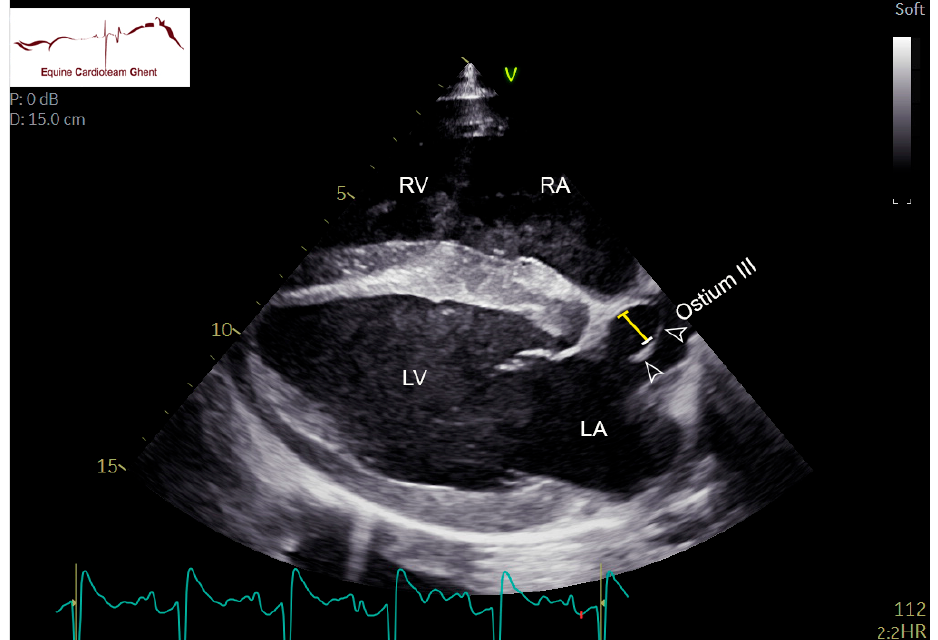
Figure 1. Right parasternal four-chamber (R-4C) view of the foramen ovale in a 2-day-old healthy foal. The arrowheads indicate the fluttering septum primum at the base of the ostium of pulmonary vein III (ostium III). The yellow bar indicates a 1 cm distance between the septum primum and septum secundum. LA: left atrium; LV: left ventricle; RA: right atrium; RV: right ventricle.